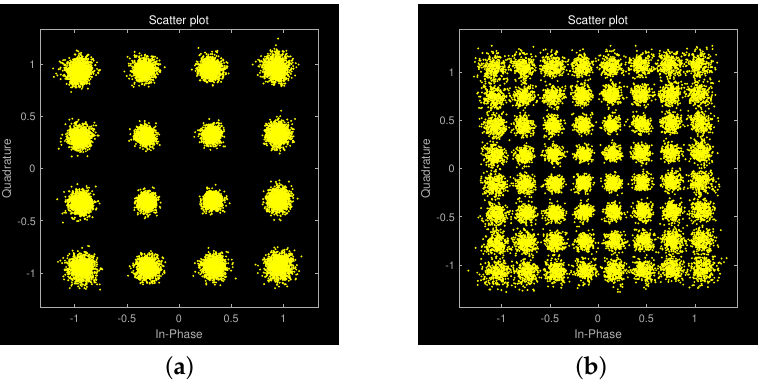
Figure 12. Received constellations under different modulation schemes. ( a ) Received constellation under 16-QAM modulation; ( b ) Received constellation under 64-QAM